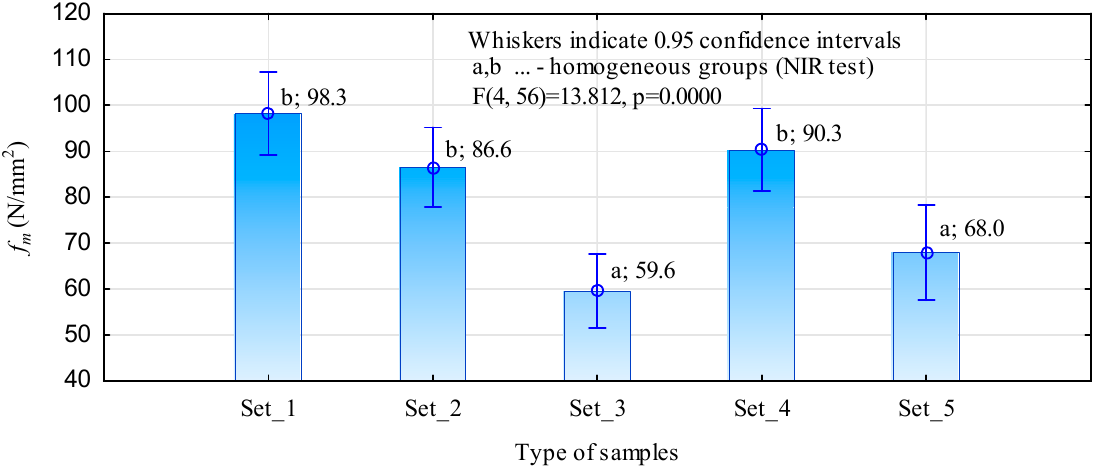
Figure 6. Static bending strength of the specimens prepared in the first stage of testing. In Figure 7, it can be seen that damage occurs directly under thrust. However, the specimens containing edge knots show the lowest static bending strength of almost 30% compared to the system where the knots were replaced by inserts (Set 3/Set_2).